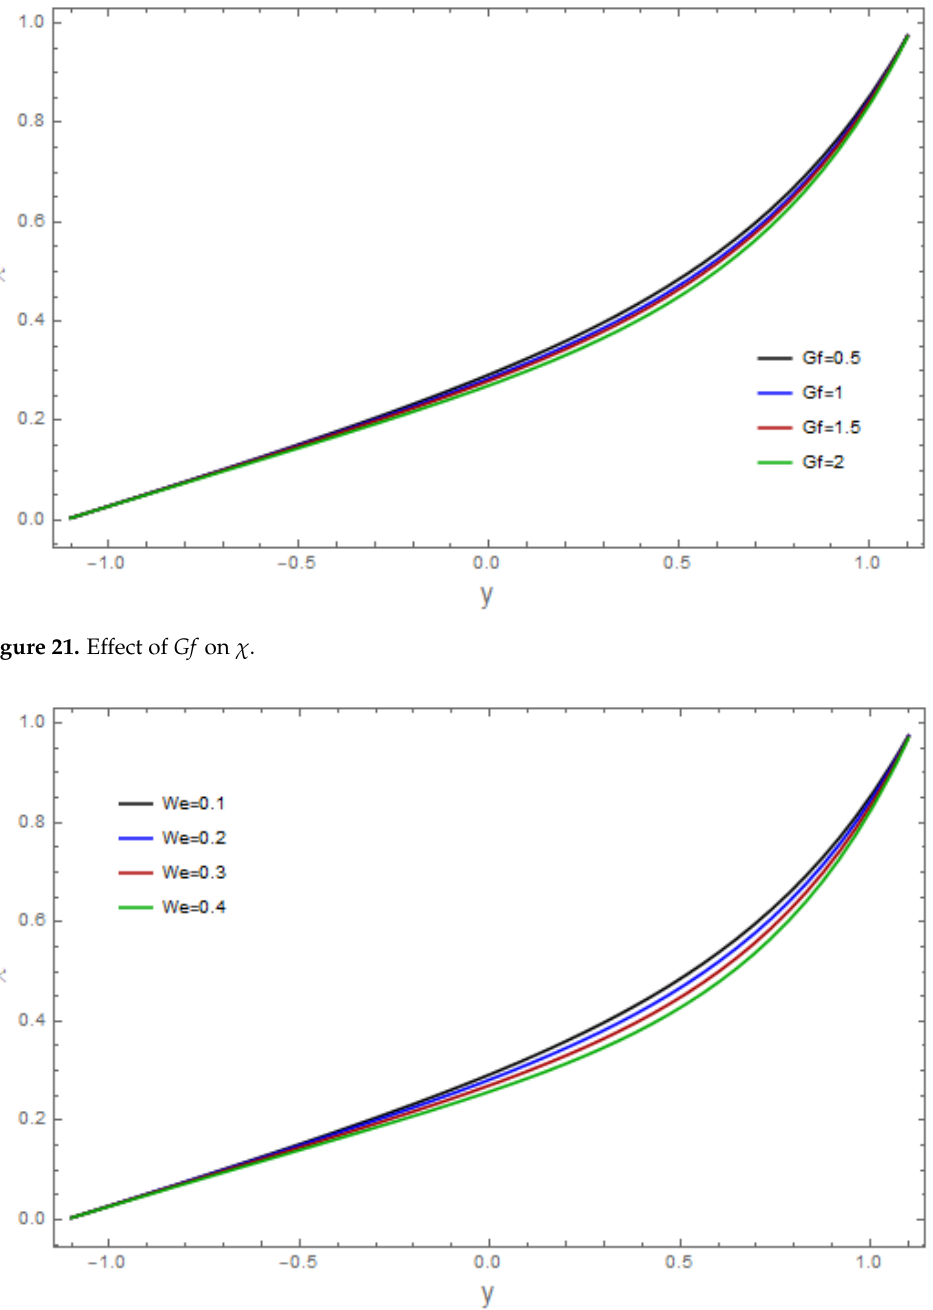
Figure 20. Effect of 𝑁𝑡 on 𝜒 .